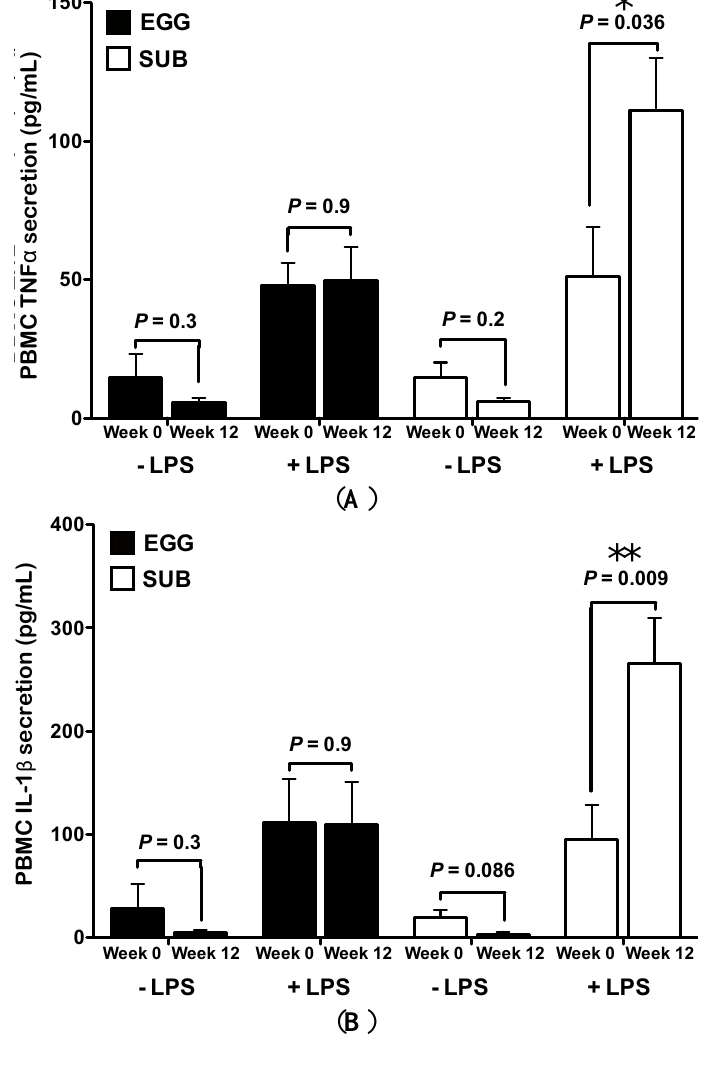
Figure 2. Egg substitute intake during carbohydrate restriction increases PBMC inflammatory responsiveness to LPS. Whole egg ( n = 5) and egg substitute ( n = 5) intake during carbohydrate restriction differentially affected LPS-induced PBMC cytokine secretion. ( A ) ELISA analysis for PBMC TNFα and ( B ) IL-1β secretion with or without stimulation with LPS for 6 h at baseline and week 12 of the dietary intervention. Data are represented as mean ± SEM. * P < 0.05, ** P < 0.01; paired t test comparing the difference between baseline vs. week 12 in SUB